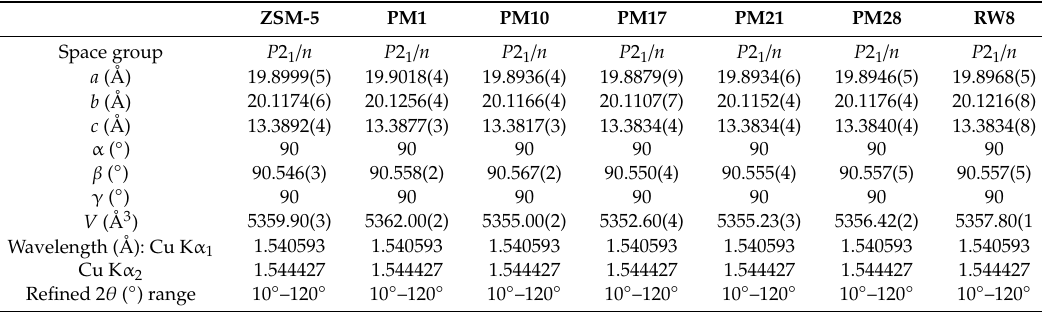
Table 3. Details of the data collection and Rietveld refinements of ZSM-5 before and after VOCs